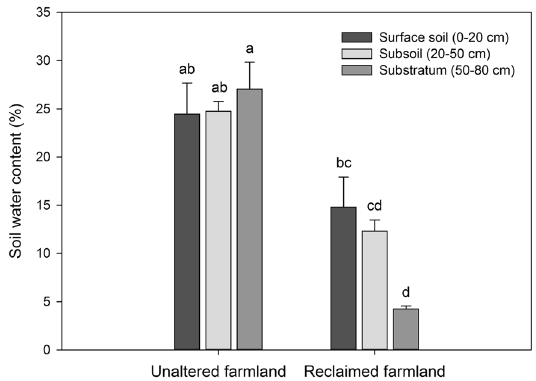
Fig. 3 Soil water content of the reclaimed and unaltered farmlands. The means with the different letters in the same columns are significantly different at the 0.05